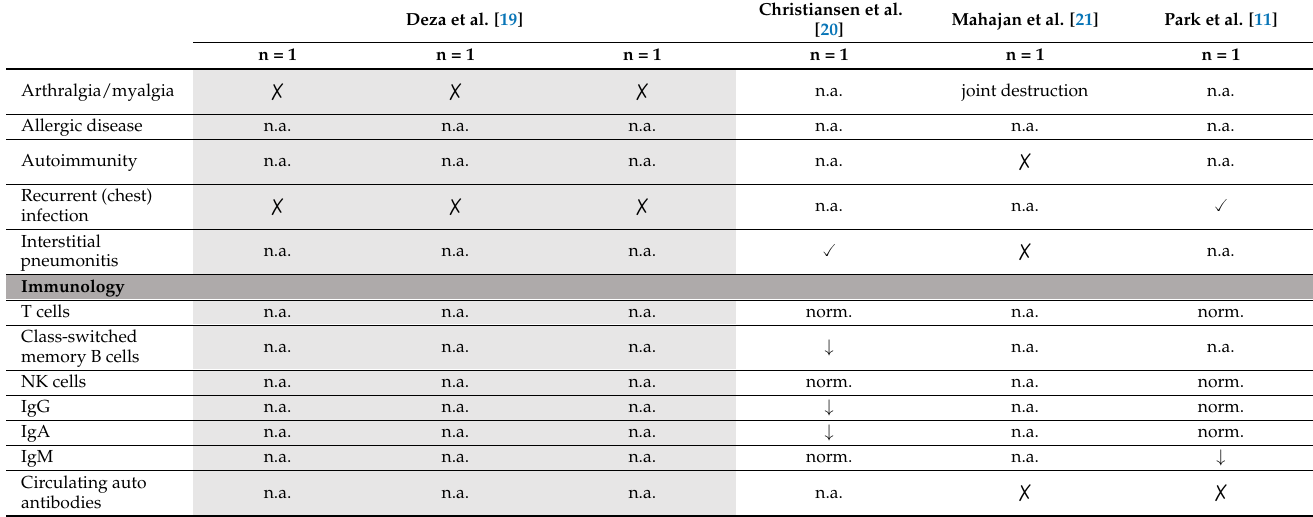
Table 1. Clinical and laboratory characteristics of patients with the heterozygous missense PLCG2 variant (c.77C>T, p.Thr26Met).